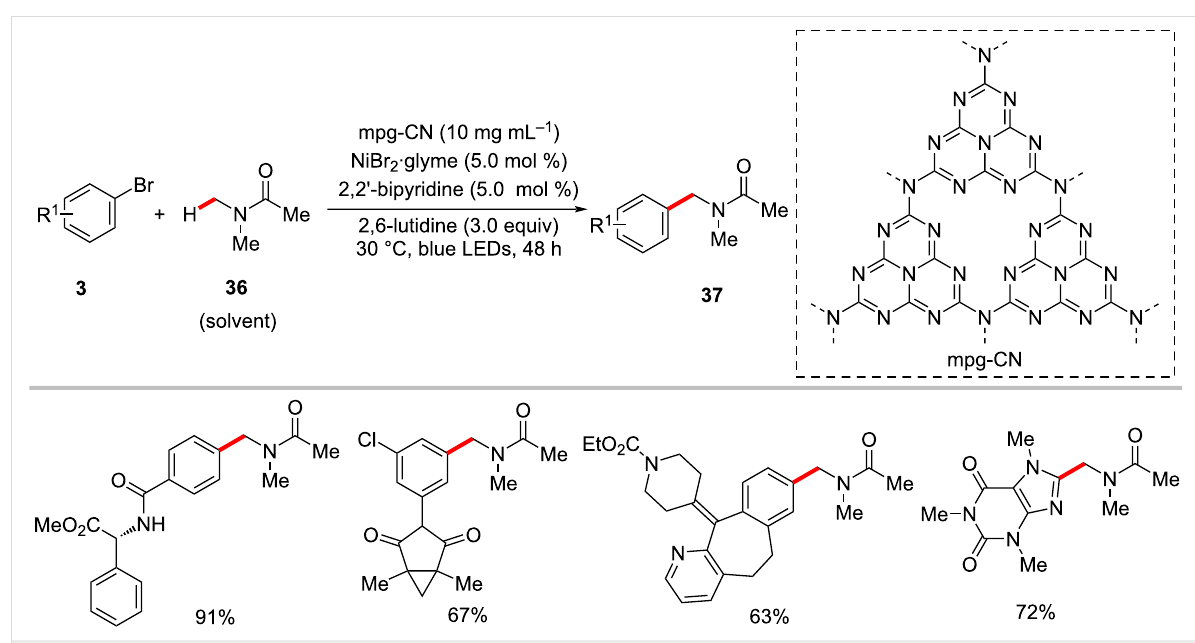
Scheme 21: C(sp 3 ) − H arylation of bioactive molecules using mpg-CN photocatalysis and nickel